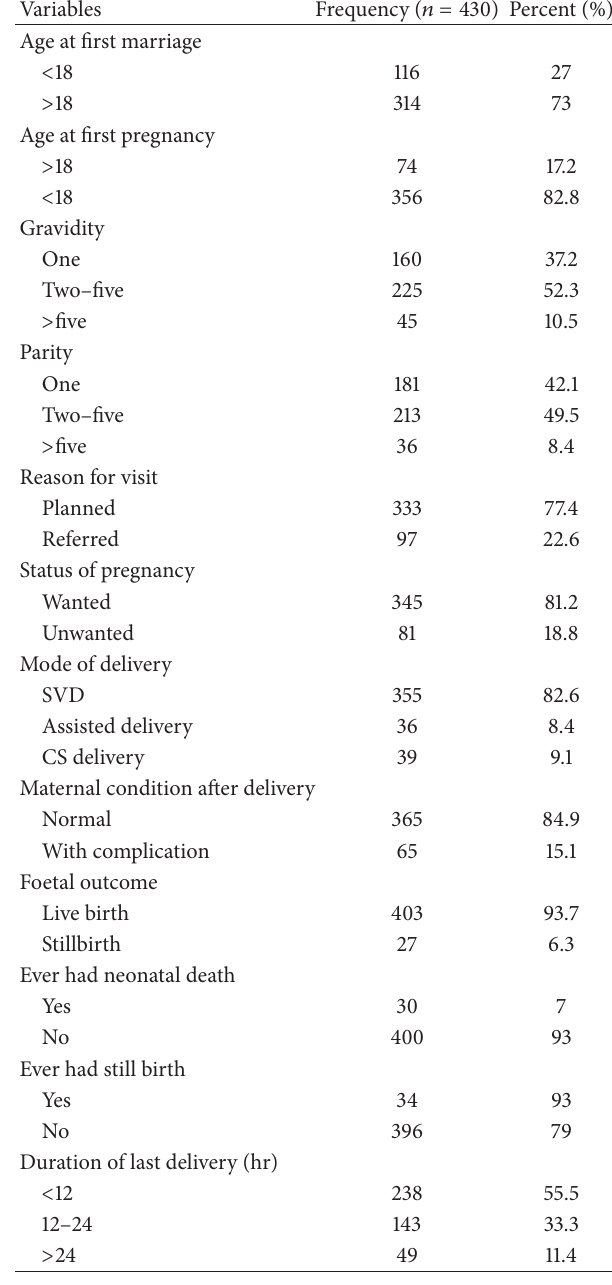
Table 2: Obstetric characteristics of respondents in Gamo Gofa Zone, southwest Ethiopia, May